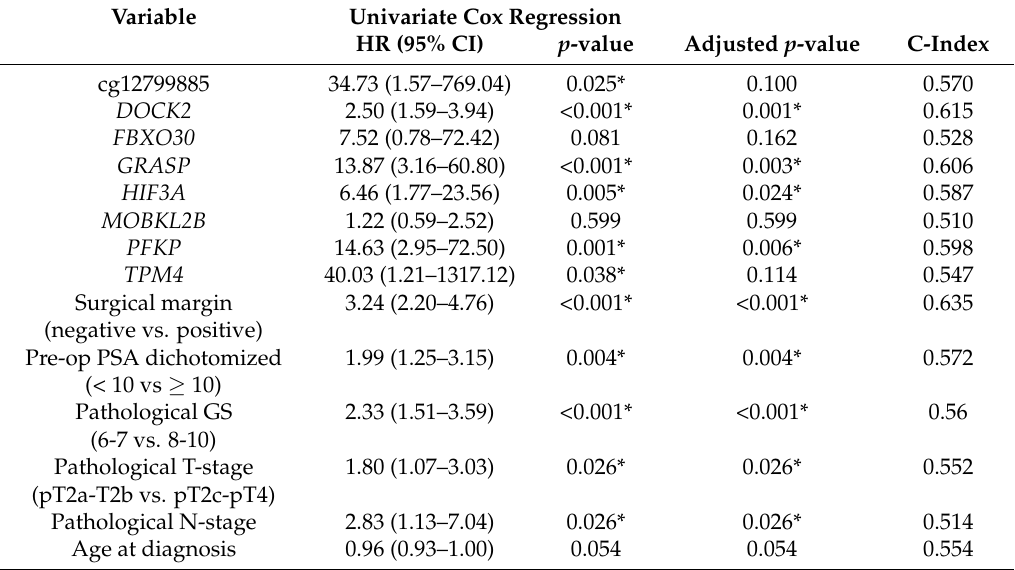
Table 2. Univariate Cox regression analysis using biochemical recurrence (BCR) after RP as endpoint. The Danish RP cohort included 234 patients in total. The methylation biomarker candidates were analyzed as continuous